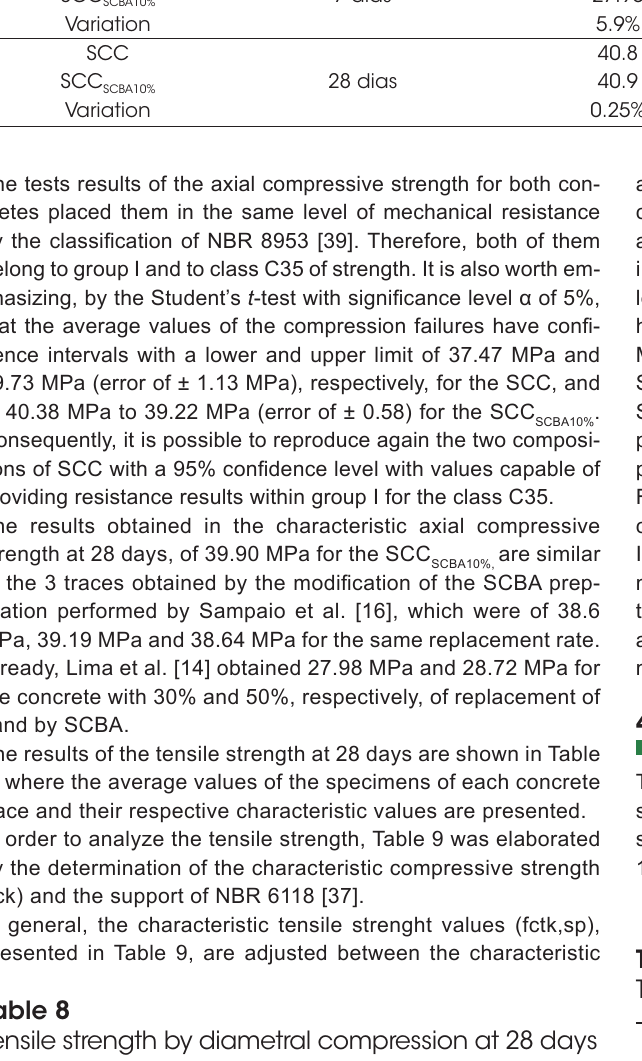
Tensile strength by diametral compression at 28 days